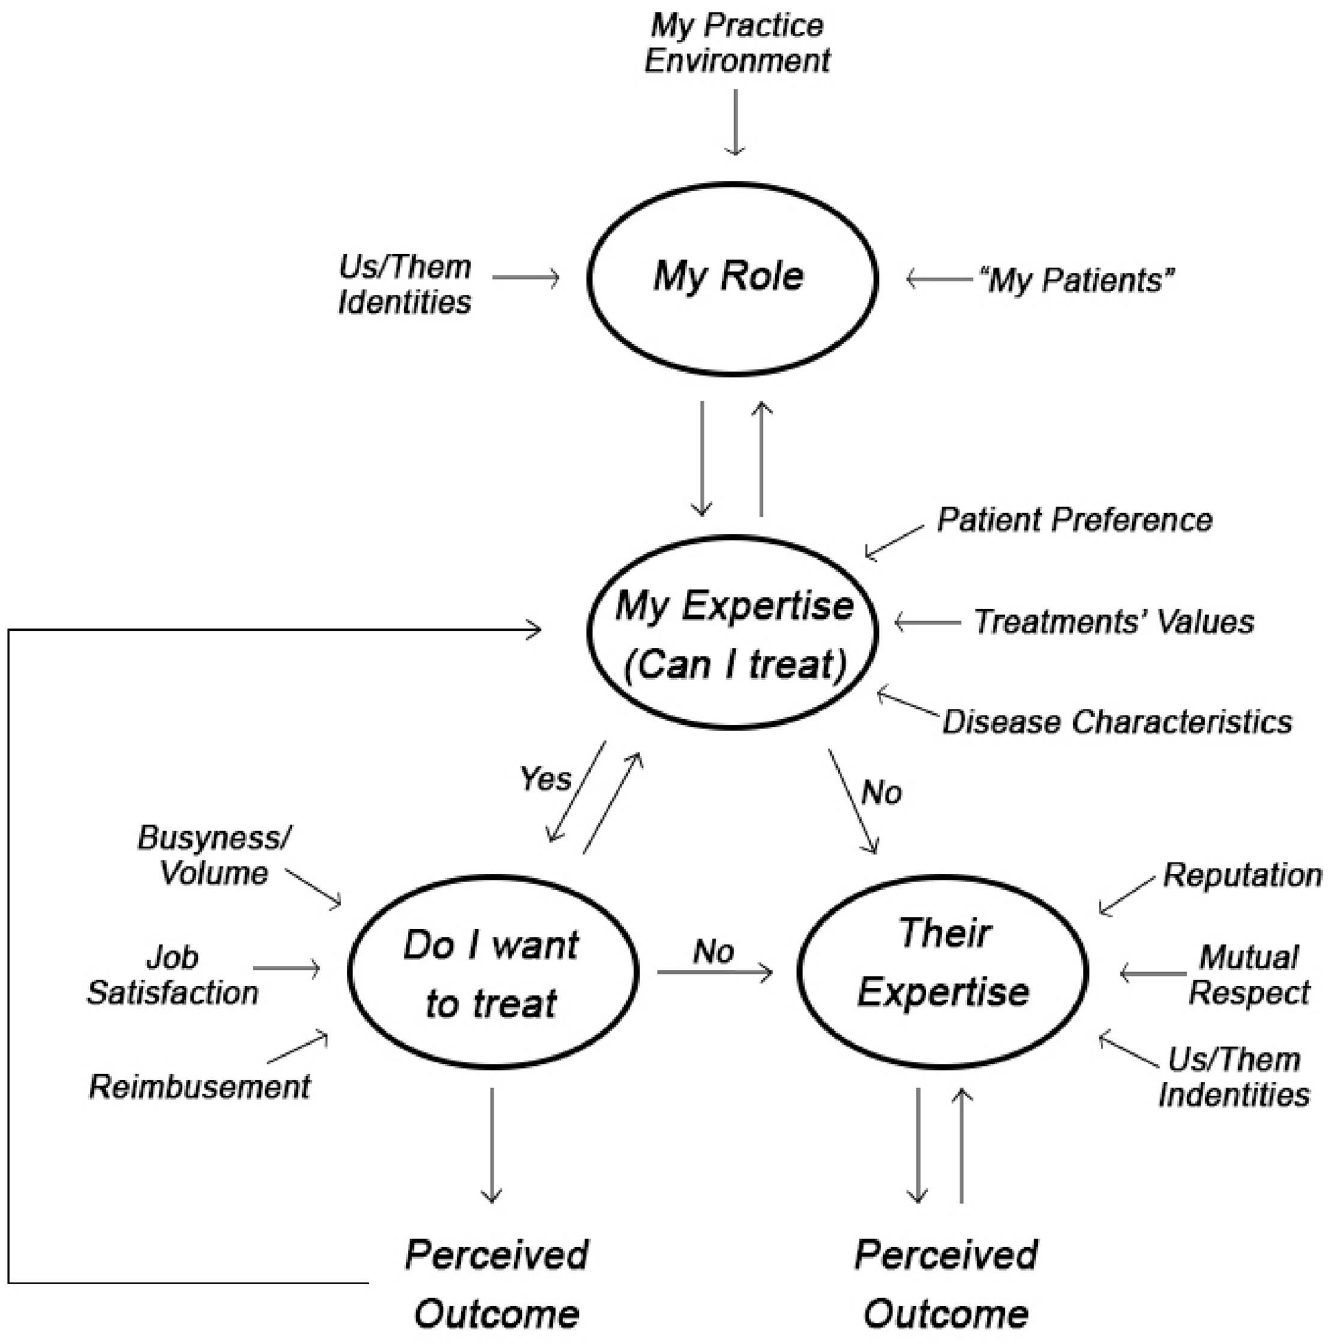
Fig 1. Summary of interviewed physicians’ decision-making framework. Visual representation of common elementsof interviewed physicians’ decision-making frameworks. Circles represent critical aspects of clinicaldecisionmaking which can be more or less influenced by the surrounding factors. The flow is circular, feedingback upon itself to represent the heavy relianceof clinical decisionmaking on past experiences.